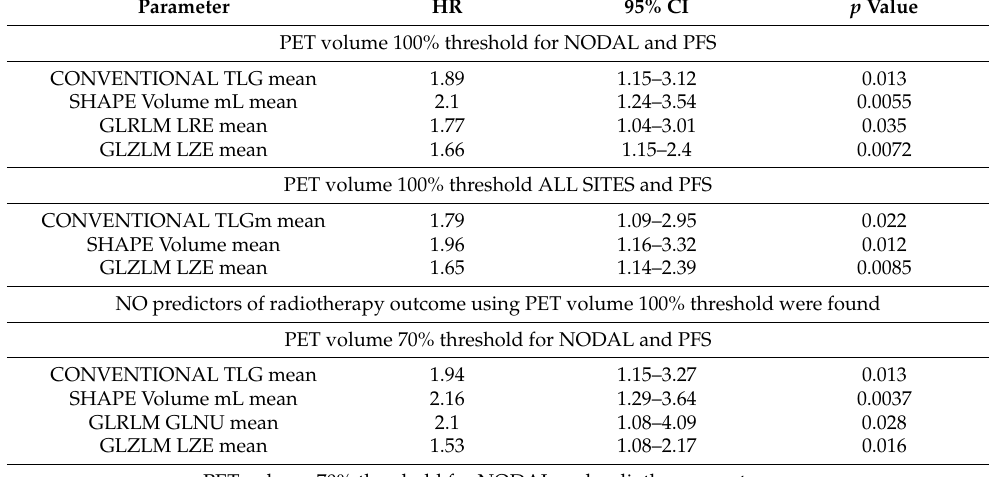
Table 4. Univariate analysis (UVA) summary of statistically significant variables for PET parameters when correlated with PFS and radiotherapy